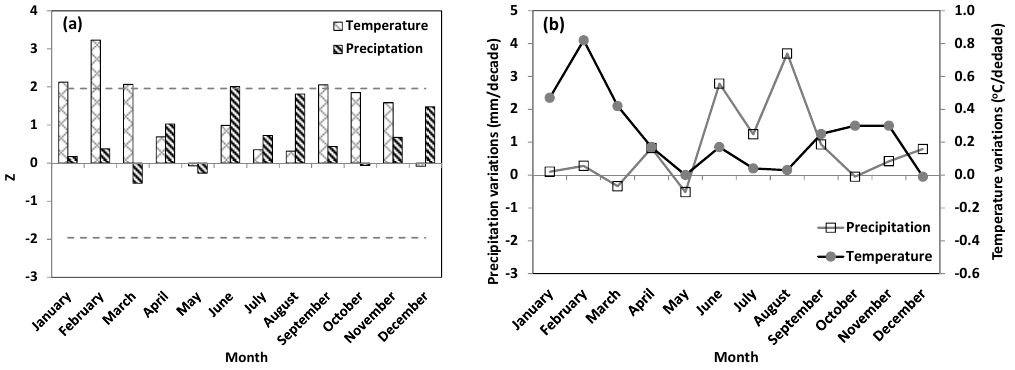
Figure 8. Z statistics ( a ) and rates of change ( b ) for monthly average temperature and precipitation from 1968 to 2007 in the Yarkant River basin at p < 0.05. The grey dotted lines in ( a ) represent the critical values of the normal distribution at p < 0.05 (Z = ±1.96). Table 3. Seasonal correlation between total runoff, glacier melt and ice melt and temperature and precipitation in the Yarkant River basin from 1968 to 2007.